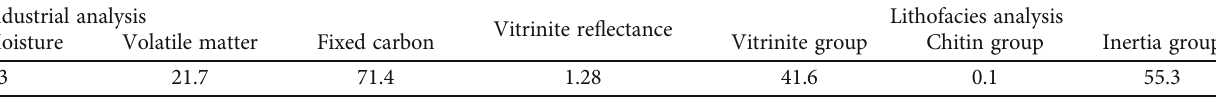
Table 2: Industrial and petrographic analysis of coal sample in Sydney Basin